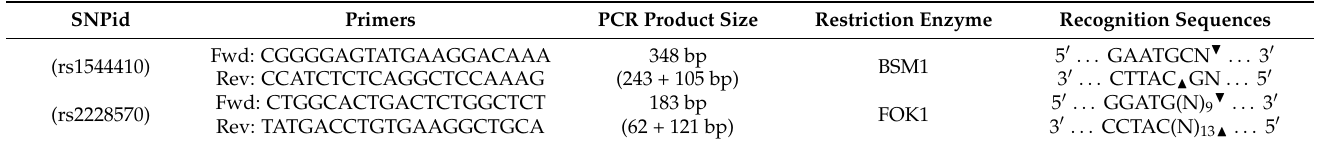
Table 1. List of primers used for PCR amplification of regions containing the polymorphism and the restriction enzymes